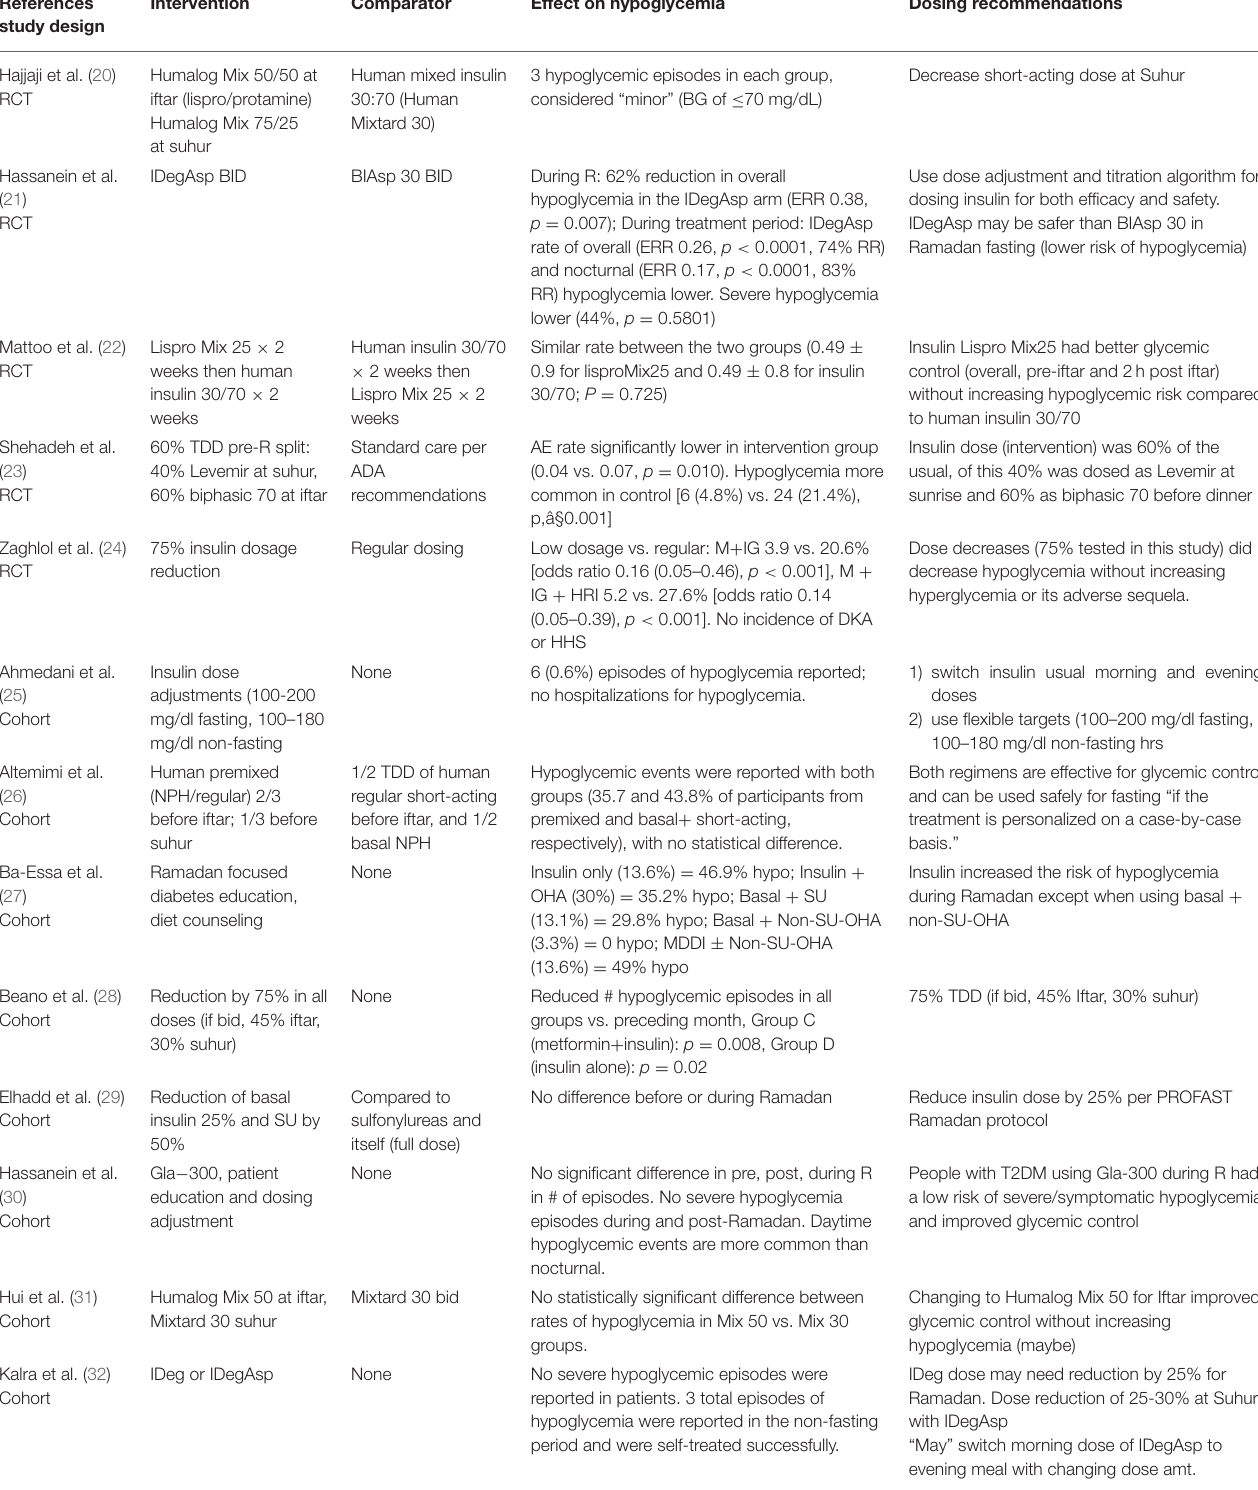
TABLE 3 | The effects of different insulin subtypes and dosing strategies on hypoglycemia. References study